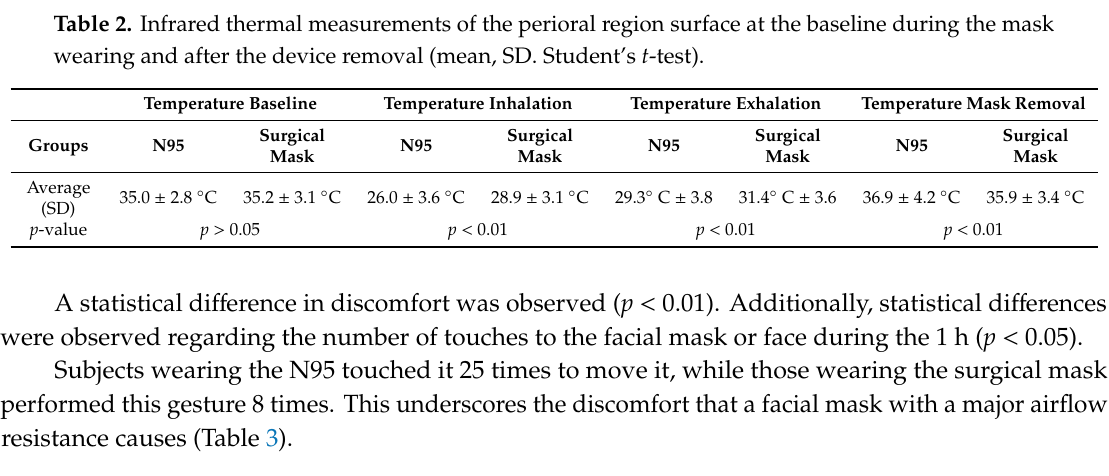
Table 3. Infrared thermal measurements of the perioral region surface. Temperature di ff erences between baseline and inhalation, between inhalation and exhalation and between baseline and mask removal. (mean, SD. Student’s t